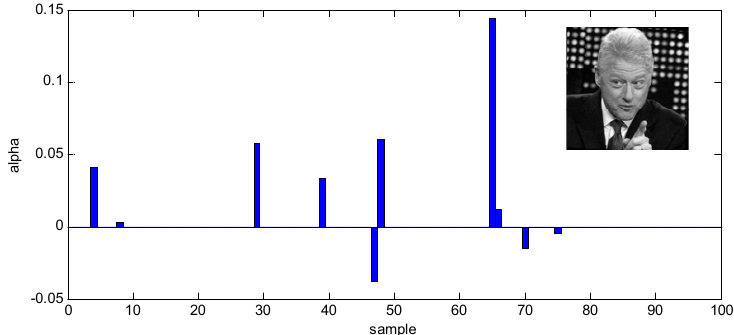
Figure 1. Sparsity reconstruction weights of one sample by Sparsity Preserving Projections (SPP) algorithm on the LFW database.